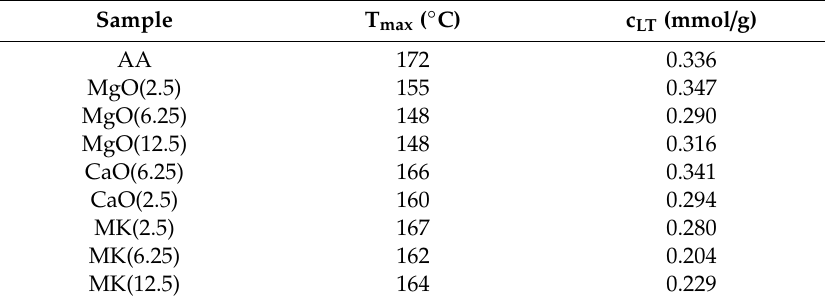
Table 4. Acidity of D2 zeolite foam pellets determined by the NH 3 -TPD